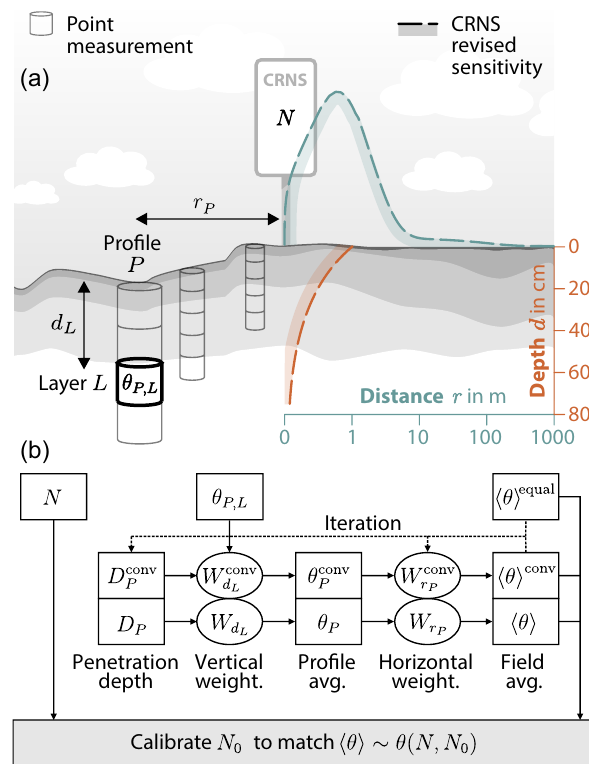
Figure 3. (a) Schematic of the environment around the cosmic-ray neutron sensor (CRNS) including point measurements (e.g., soil samples) of water equivalent θ to calibrate or validate the sensor. The revised sensitivity functions W r (teal) and W d (brown) are indicated (arb. scale). (b) The measured variables are used in the weighting procedure (Sect. 2.3), starting with an initial estimate of field-average water content. Three approaches, using the equal , the conventional (conv), and the revised weighting function are com- pared in this study. The resulting weighted-average water equiva- lent (cid:104) θ (cid:105) is then used to calibrate against or validate with the CRNS product (Eq. 1). Calibration of the parameter N 0 is performed to- wards optimization of four performance measures (see Sect.